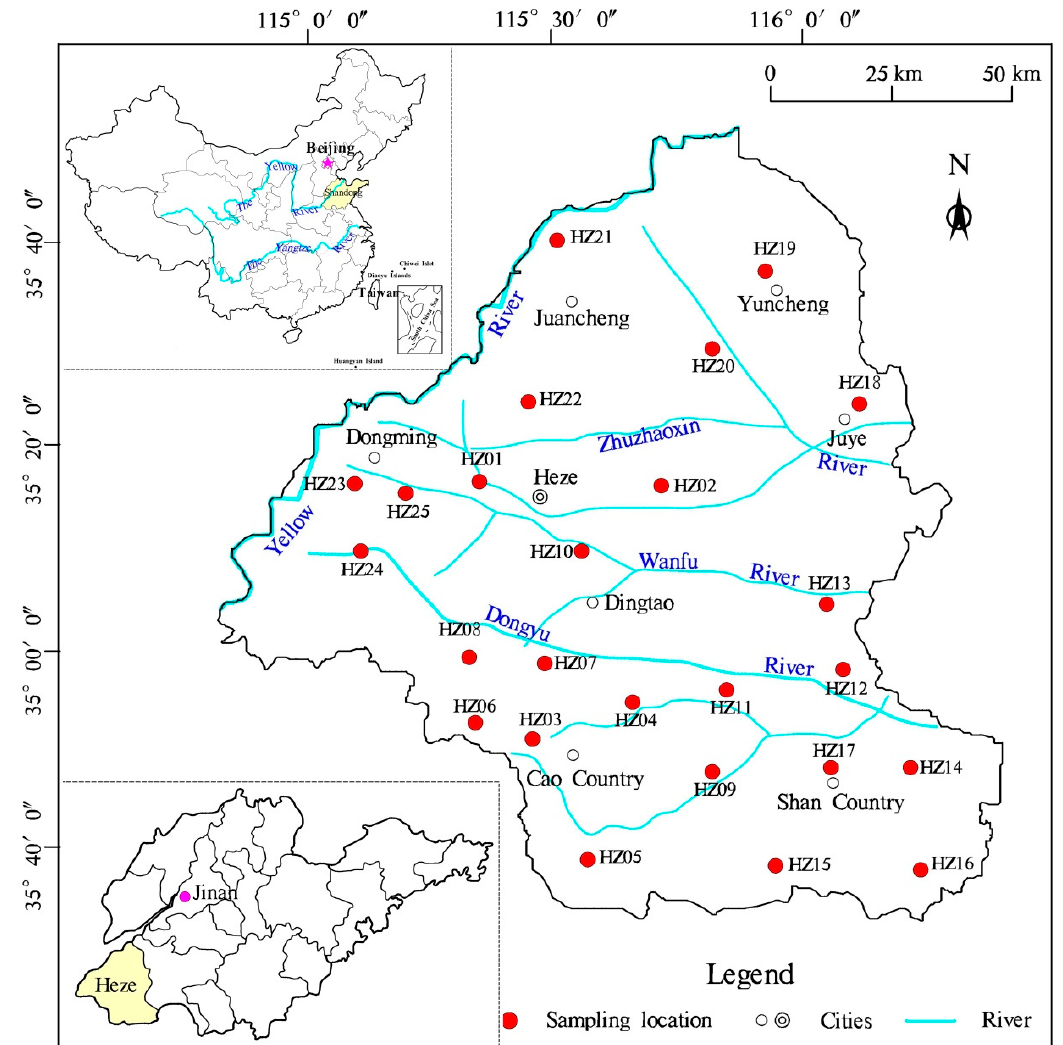
Figure 1. Location of the sampling sites and the study area.